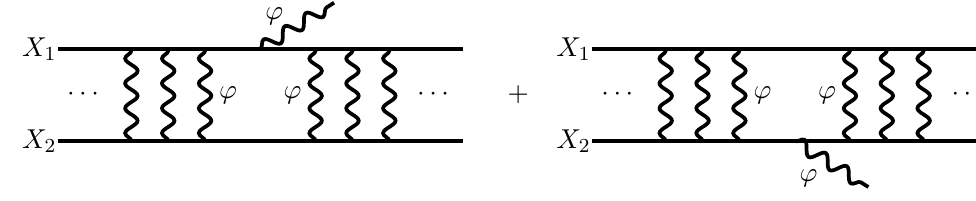
Figure 1b . The diagrams contributing in leading order, to the formation of bound states with emission of a force mediator. For this transition, the ladder to the left of the radiative vertex corresponds to the initial scattering state, while the ladder to the right corresponds to a bound state. The mediator can be either a scalar or a vector